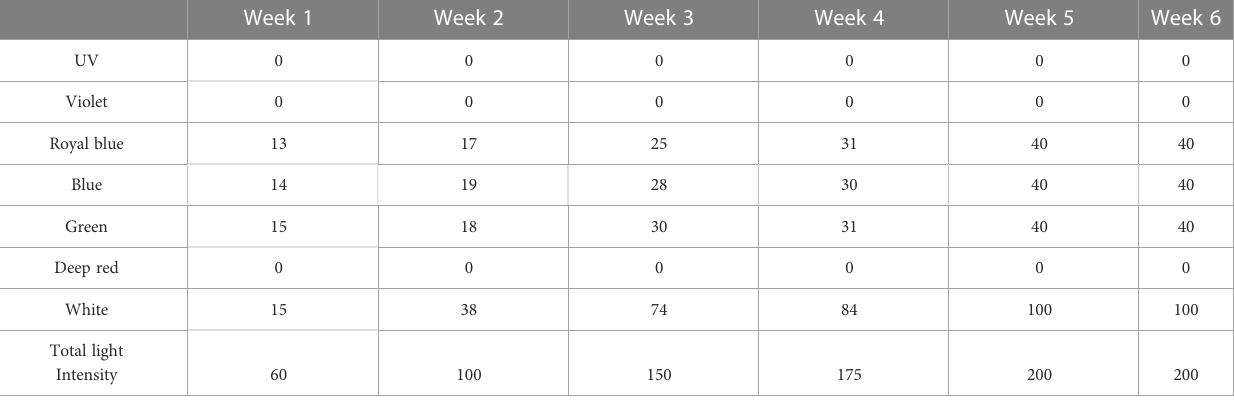
TABLE 1 Percentage of each light spectrum (%) that was programmed for the LED lamps and total PAR irradiance ( m mol photons m − 2 s − 1 ) that was recorded at the bottom of the